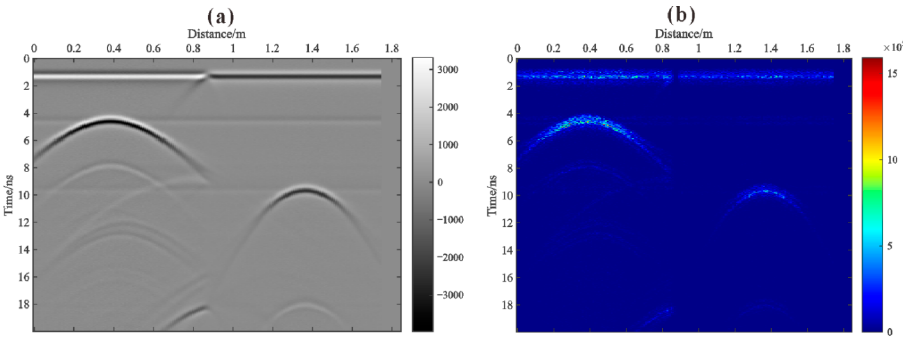
Figure 7. ( a ) GPR B-scan based on the forward model and ( b ) the derived profile by directly per- forming the TKEO.